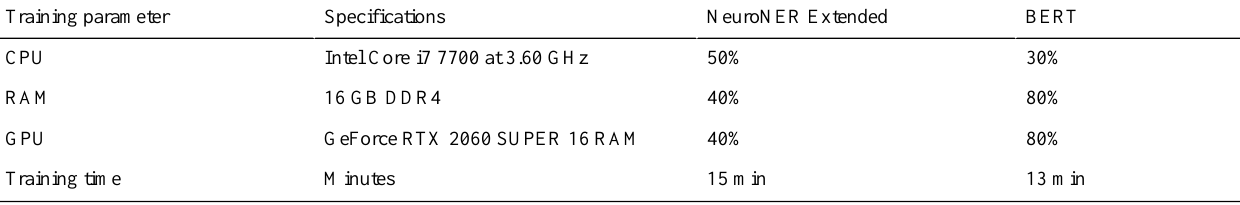
Table 24. Training parameters for the deep learning